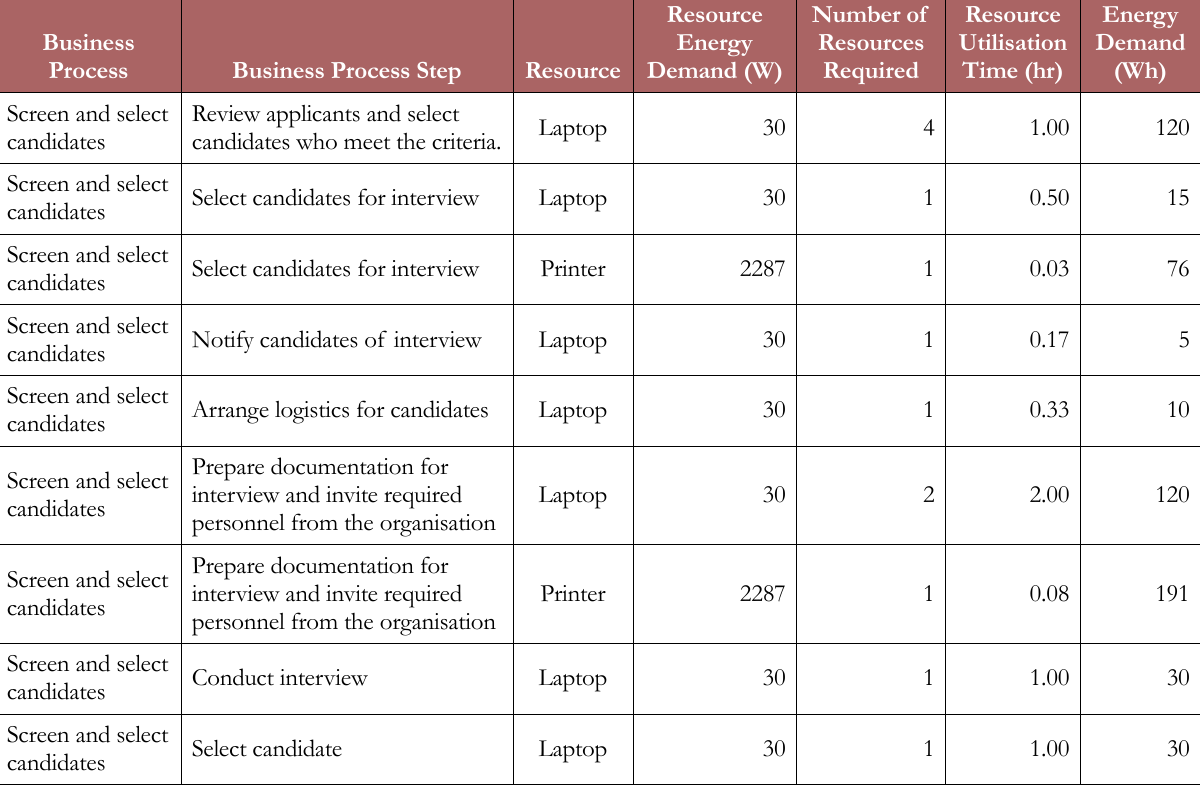
Table 1. Calculation of energy demand for the screen and select candidate business